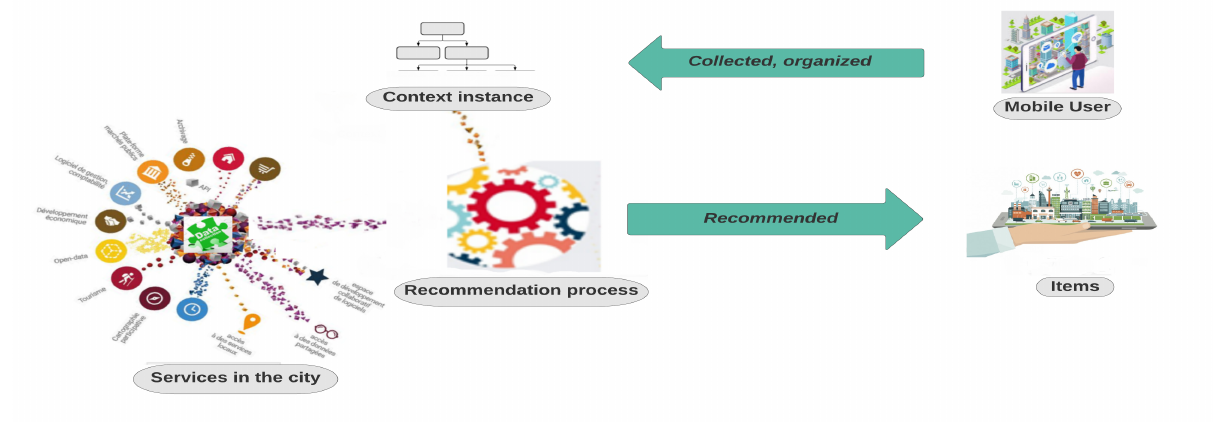
Figure 1. General view of a personalized mobile service recommendation